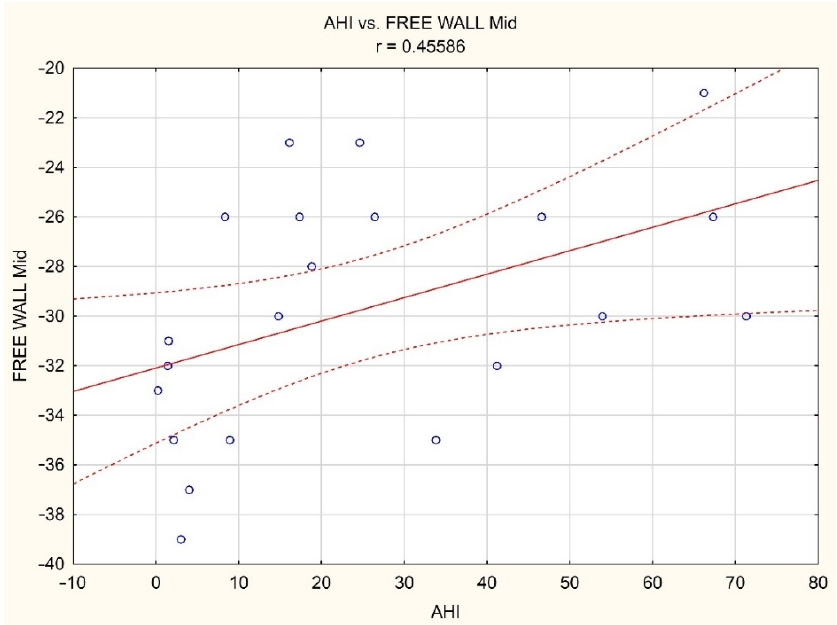
Figure 1. Correlation between AHI and RV mid free wall strain in the study subgroup with age below 60 years (red solid line—estimation curve, dashed lines—95% confidence interval of the estimation curve, small blue circles—individual cases).